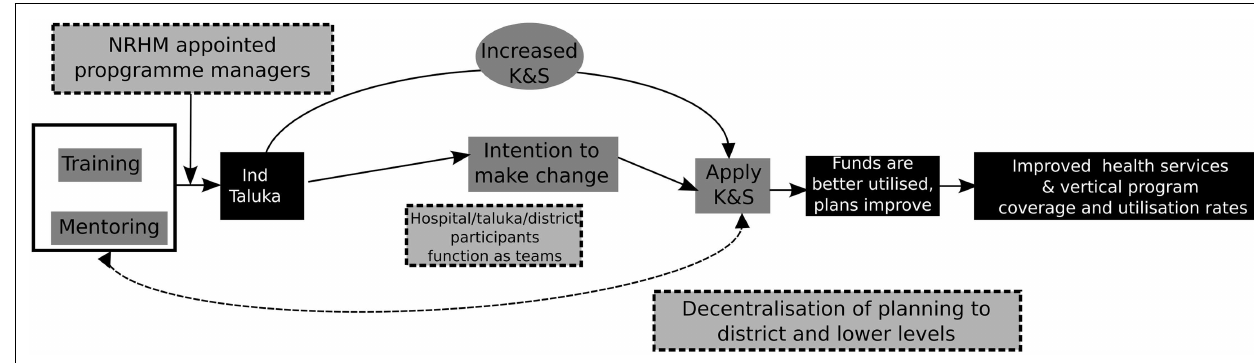
FIGURE 3 | Program theory of the intervention after incorporating the assumptions of the implementers .